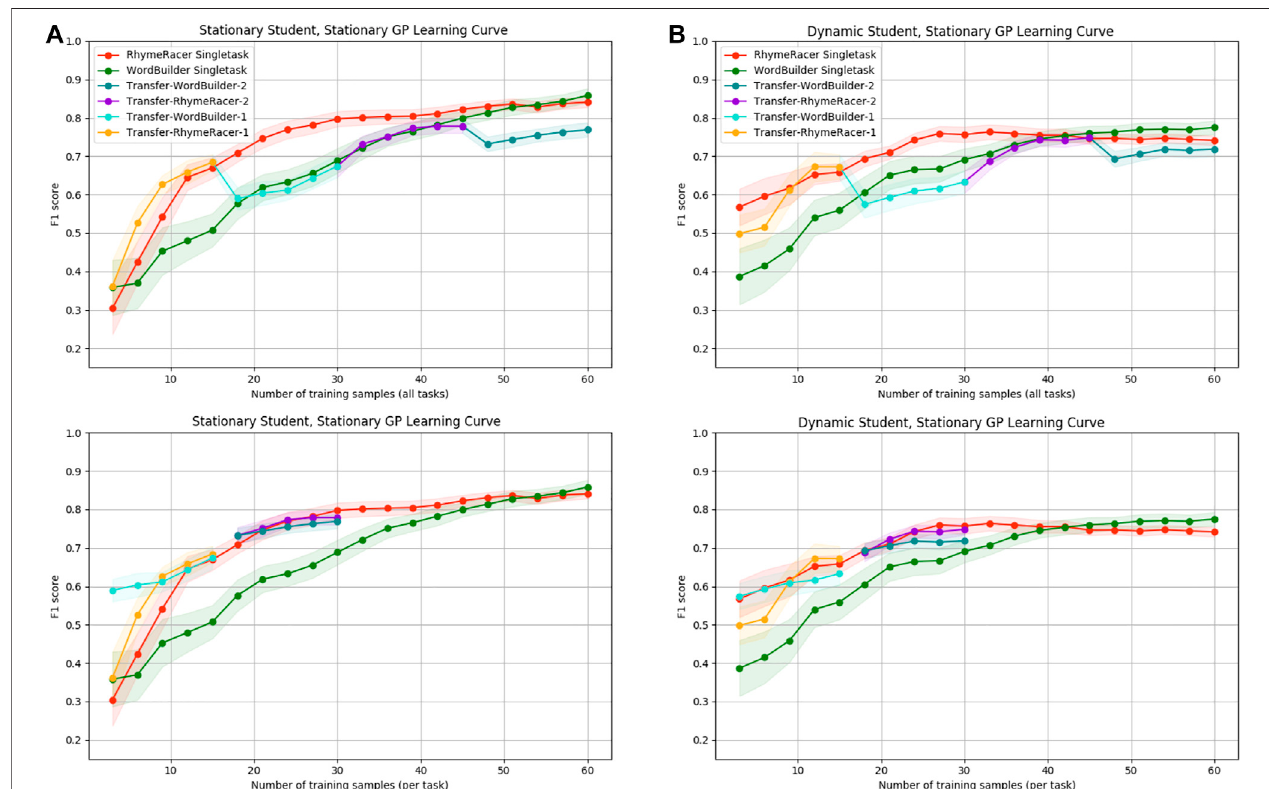
FIGURE 8 | Static-model-static-student performance results (A) vs. static-model-dynamic-student performance results (B) . Static models can learn a decent model but suffer a drop in fi nal pro fi ciency. Ef fi ciency bene fi ts of multitask model are undiminished.